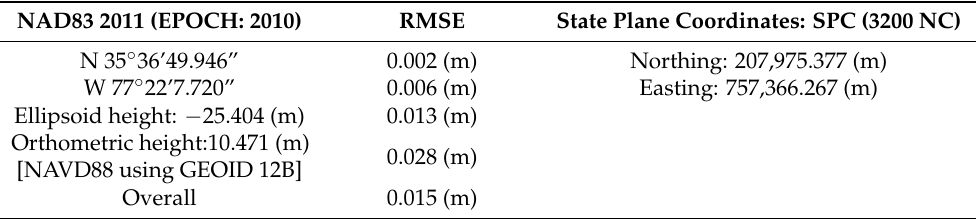
Table 1. Online Positioning User Service (OPUS) solution for the benchmark established in this